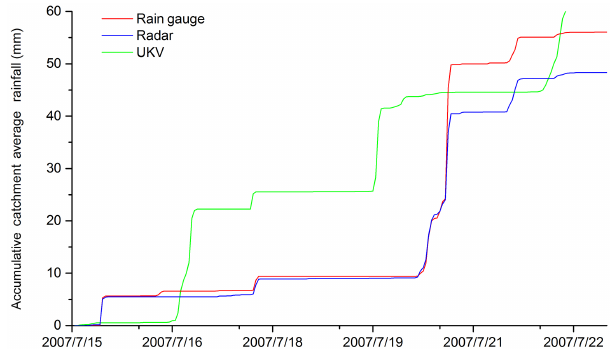
Figure 10. The comparison of flow simulation in HYPE (event July